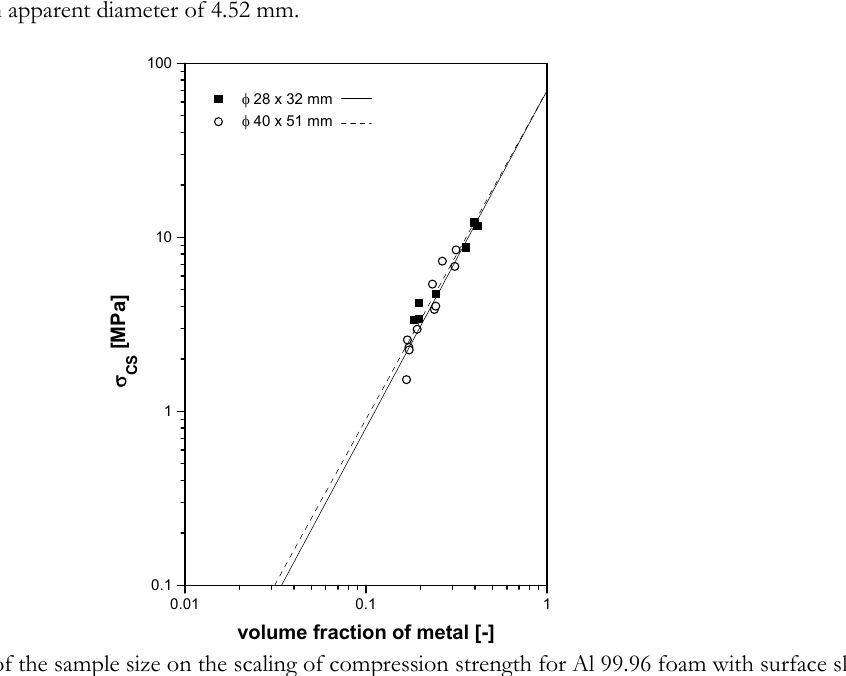
Figure 5: Effect of the sample size on the scaling of compression strength for Al 99.96 foam with surface